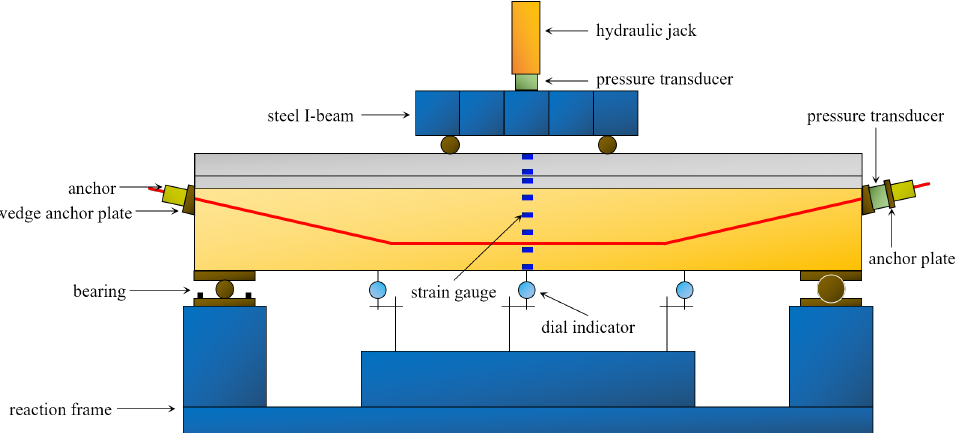
Figure 7. Loading diagram of bending test.